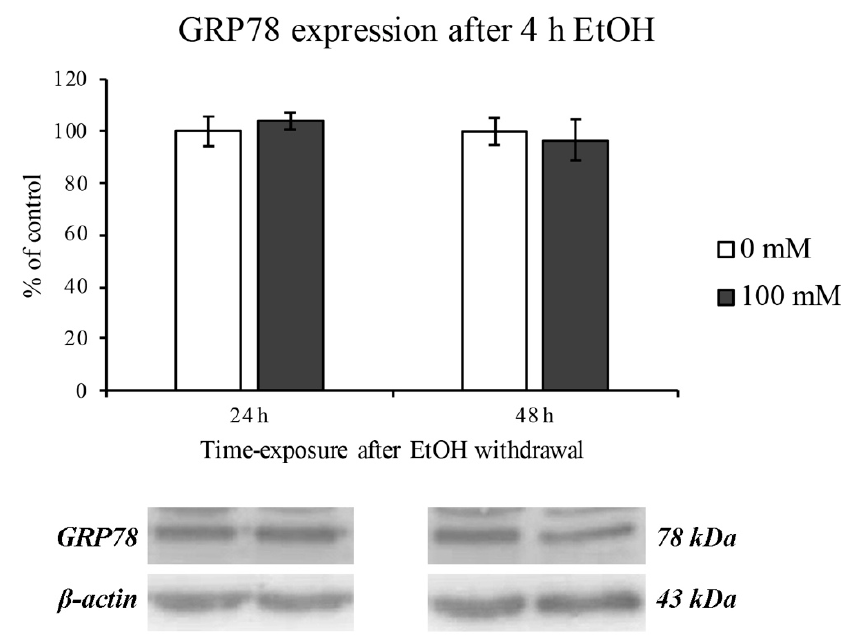
Figure 6. ER stress (GRP78 expression) on RBE4 cells after EtOH withdrawal. Western blotting analysis and quantification of GRP78 expression levels after 24 and 48 of EtOH 100 mM (4 h treatment) withdrawal. Values are expressed in percentage of control (untreated cells) as the mean ± S.E.M. of three independent experiments in